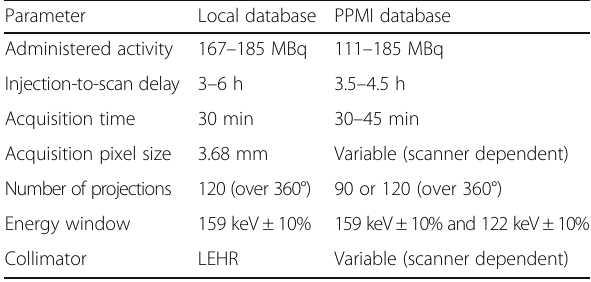
Table 1 Summary of the acquisition and patient preparation parameters for the local and PPMI